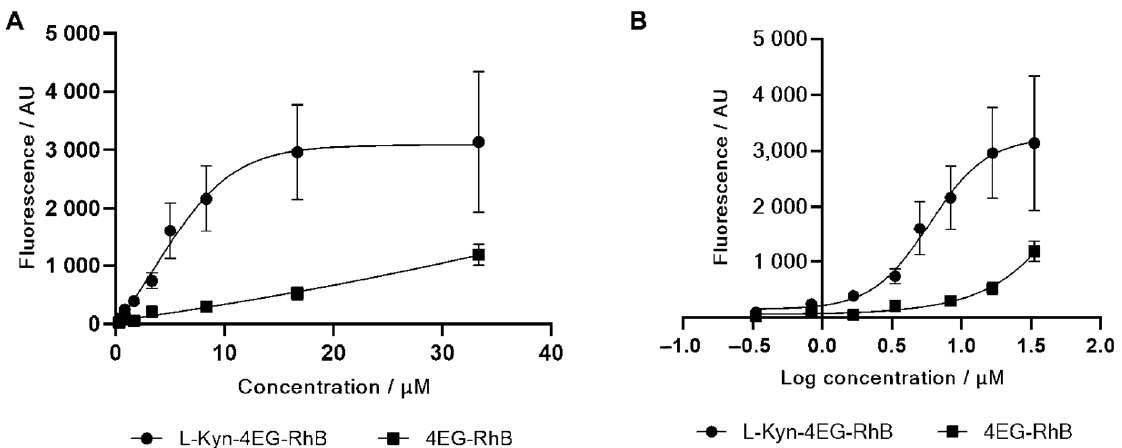
Figure 3. Binding assay of L-Kyn-4EG-RhB conjugate 5 and 4EG-RhB control 6 with antibody-coated magnetic beads ( A ) Concentration in micromole per liter and ( B ) logarithmic analyte concentration. Binding of the conjugate 5 to the antibody is significantly stronger than binding of the 4EG-RhB control 6 . A specific binding of the conjugate to the antibody is concluded.